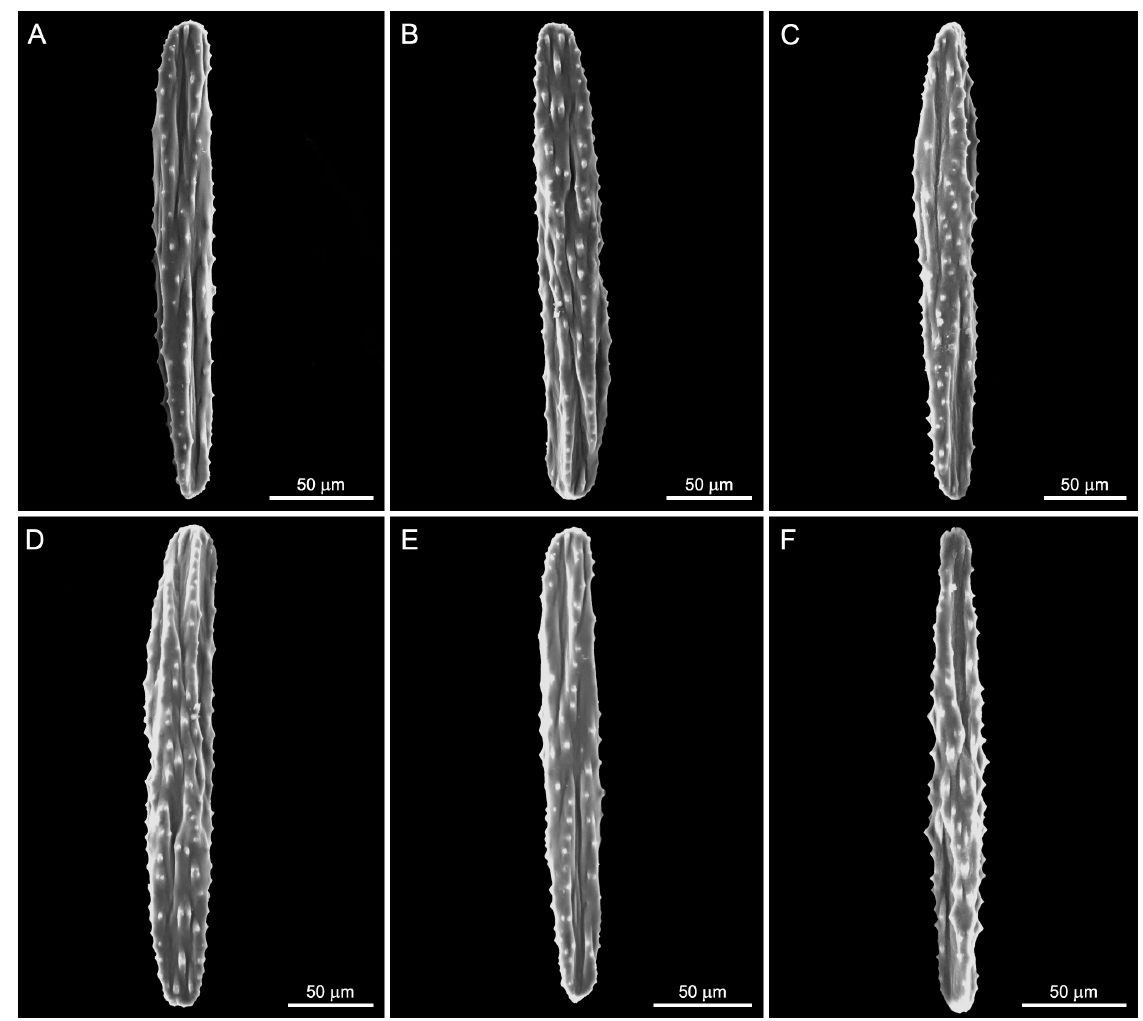
Fig. 7. Variability of sizes and ornamentations of the pinnules’ sclerites of the holotype of Umbellula pomona Risaro, Williams & Lauretta sp. nov. (MACN-IN